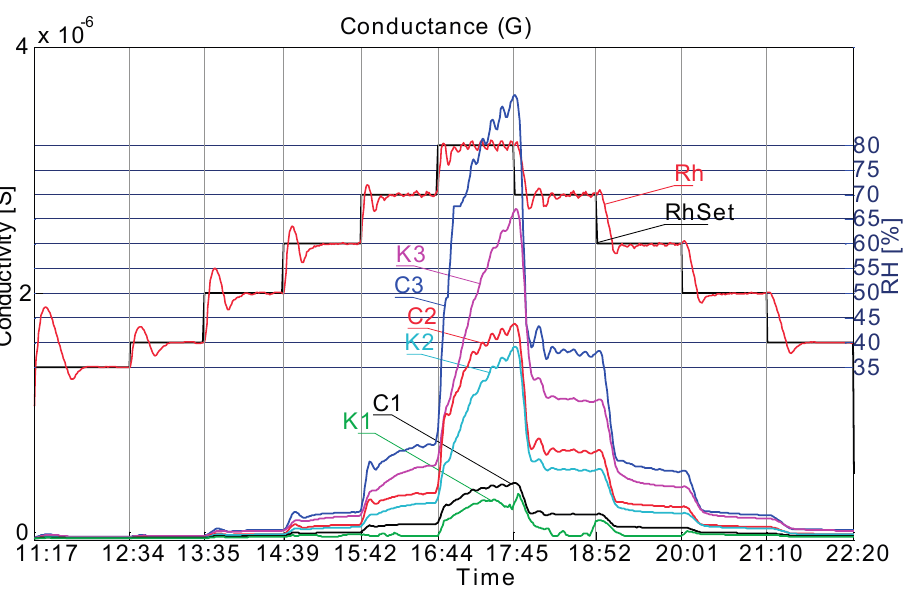
Figure 8. Conductance of comb type sensors on recycled paper and